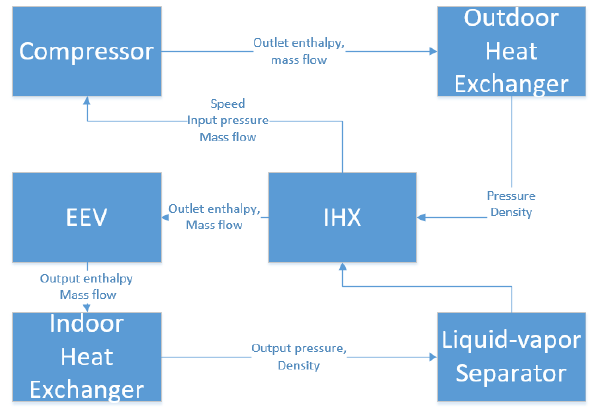
Figure 3. The simulation flow